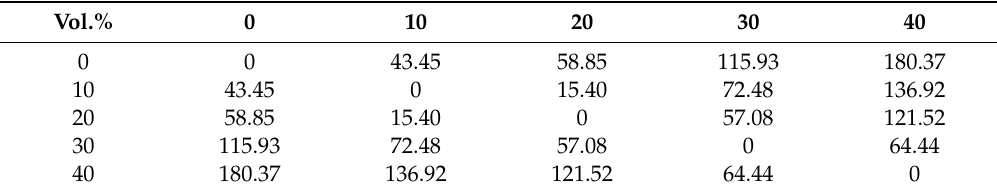
Table 5. Results obtained for the di ff erences (LSD) between the average values of the Izod impact energy, in the volume fractions of carnauba fibers from 0 to 30 vol%, after application of the Tukey test.